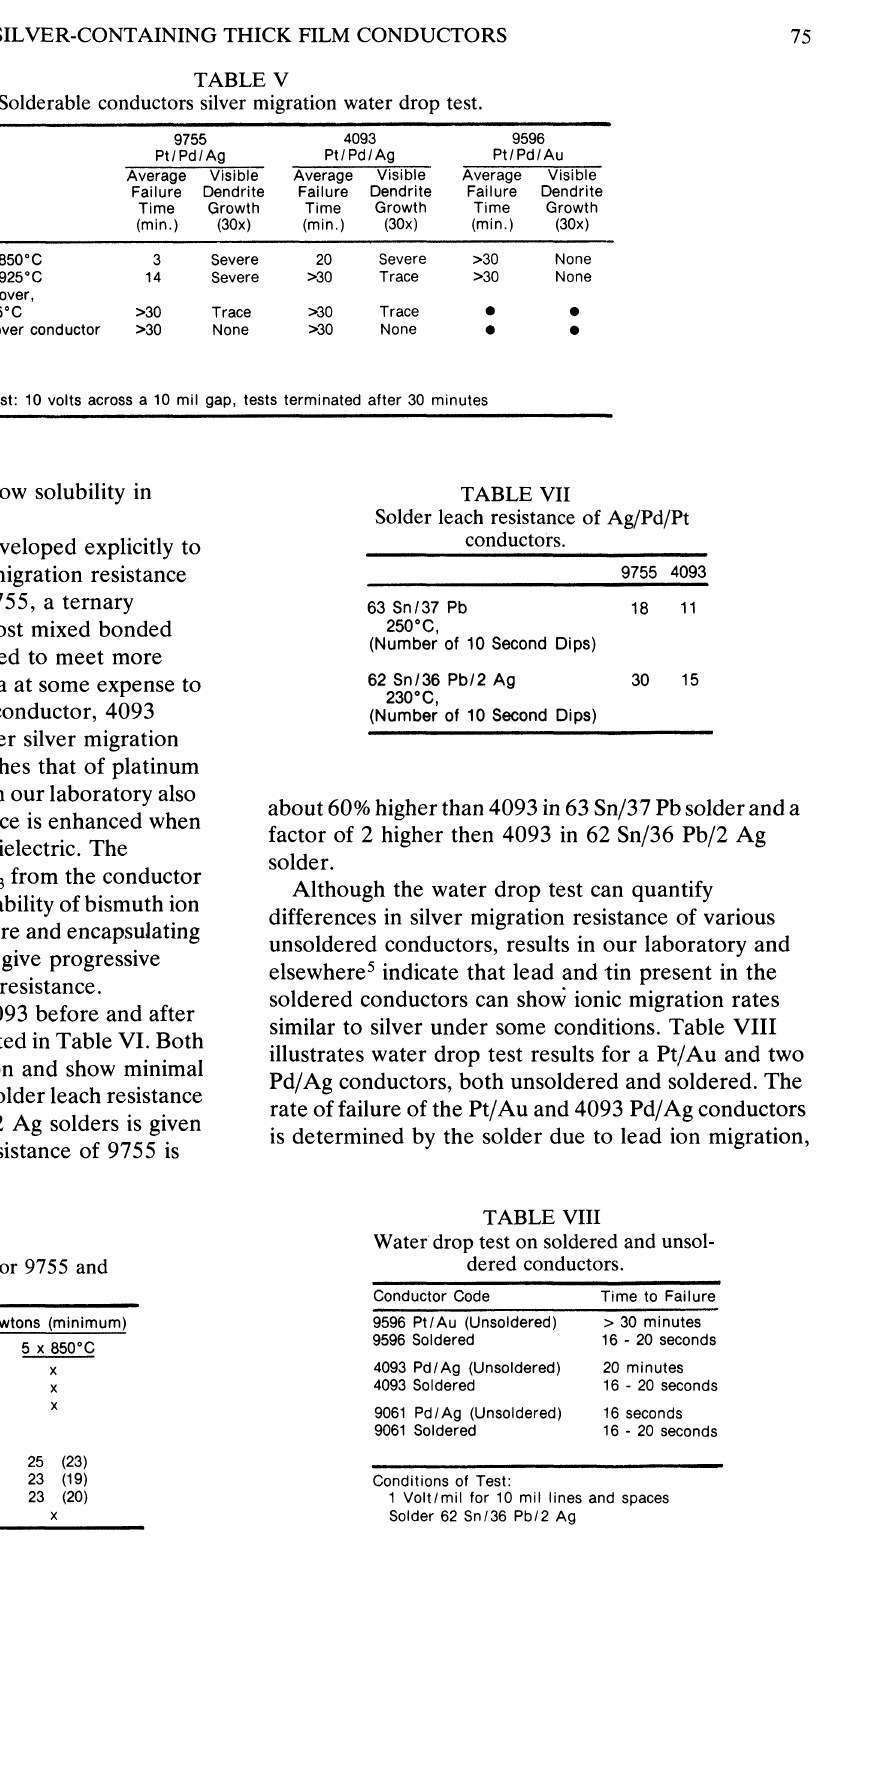
TABLE V Solderable conductors silver migration water drop test.